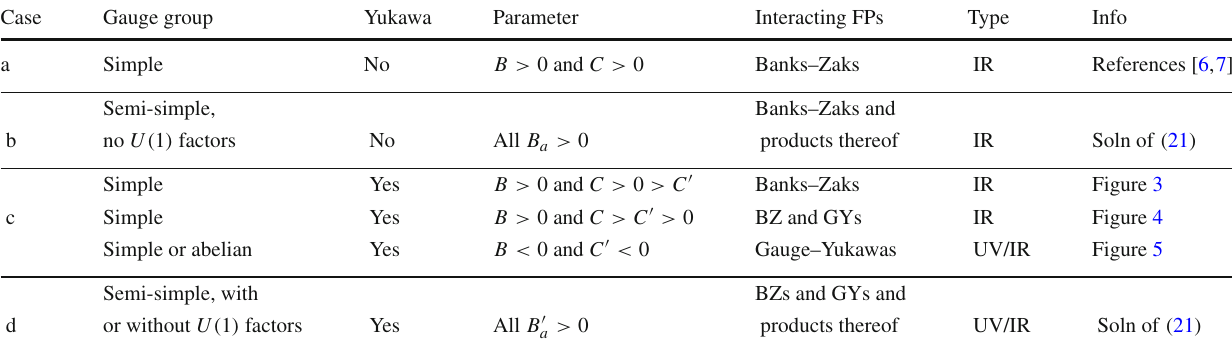
Table 3 Summary of weakly interacting fixed points in gauge theories, detailing the availability of Banks–Zaks (BZ) or gauge–Yukawa (GY) type fixed points, or combinations and products